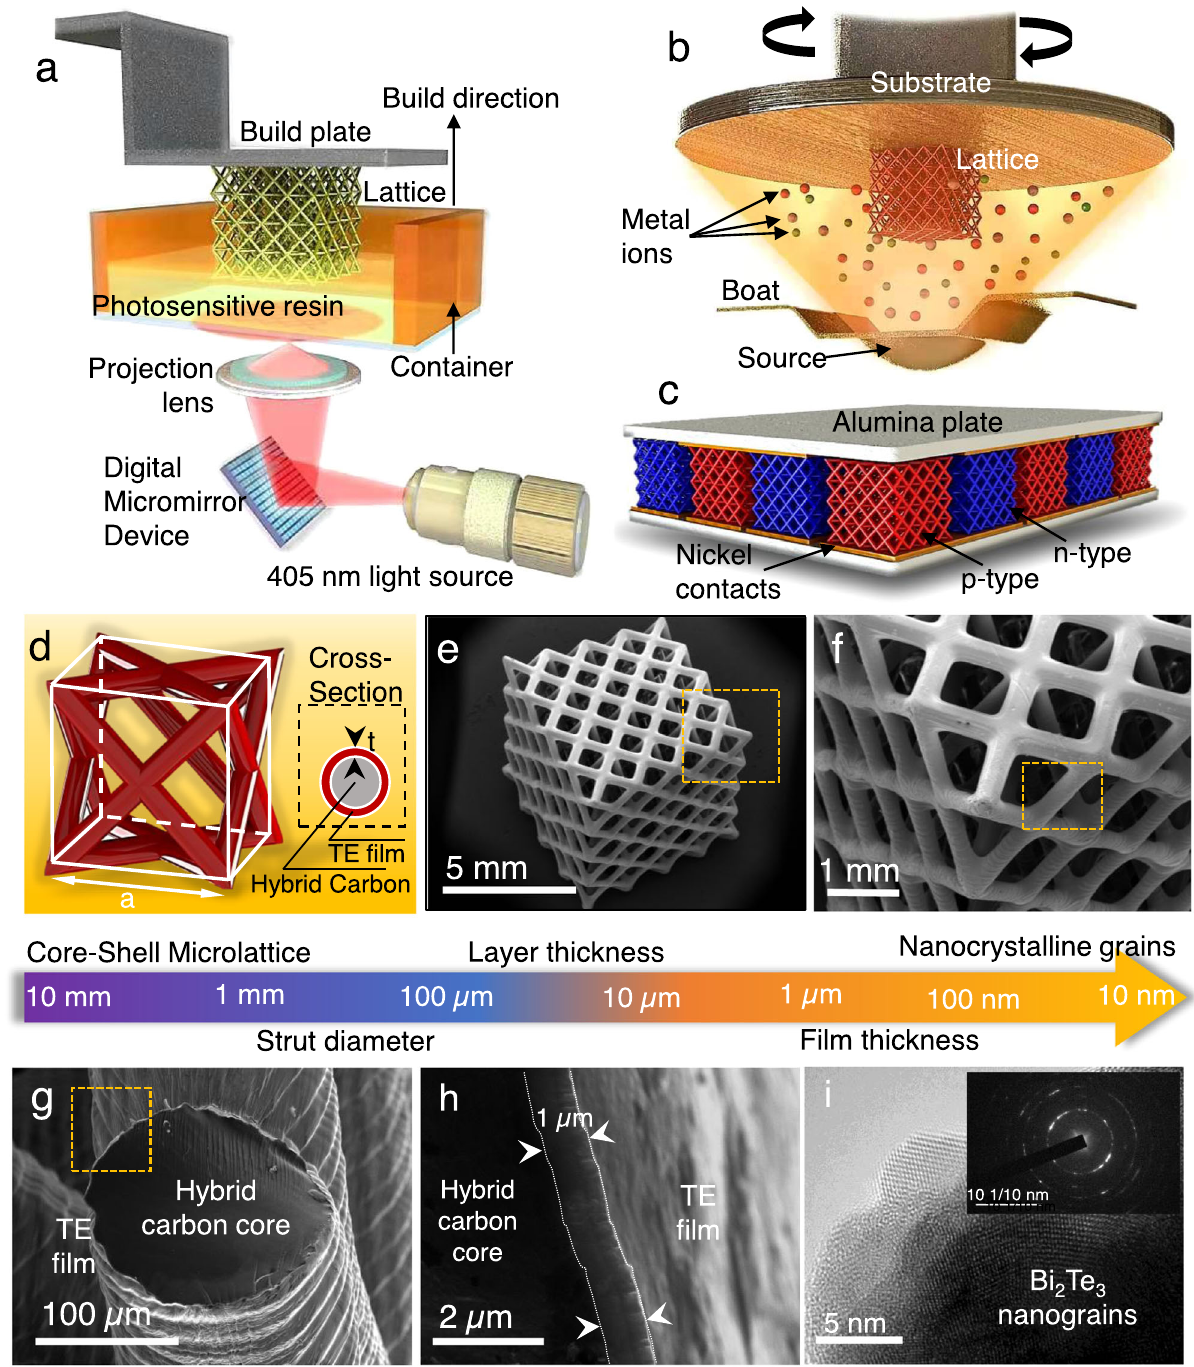
Fig. 1 | Fabrication of 3D architected thermoelectric generators (TEGs). a